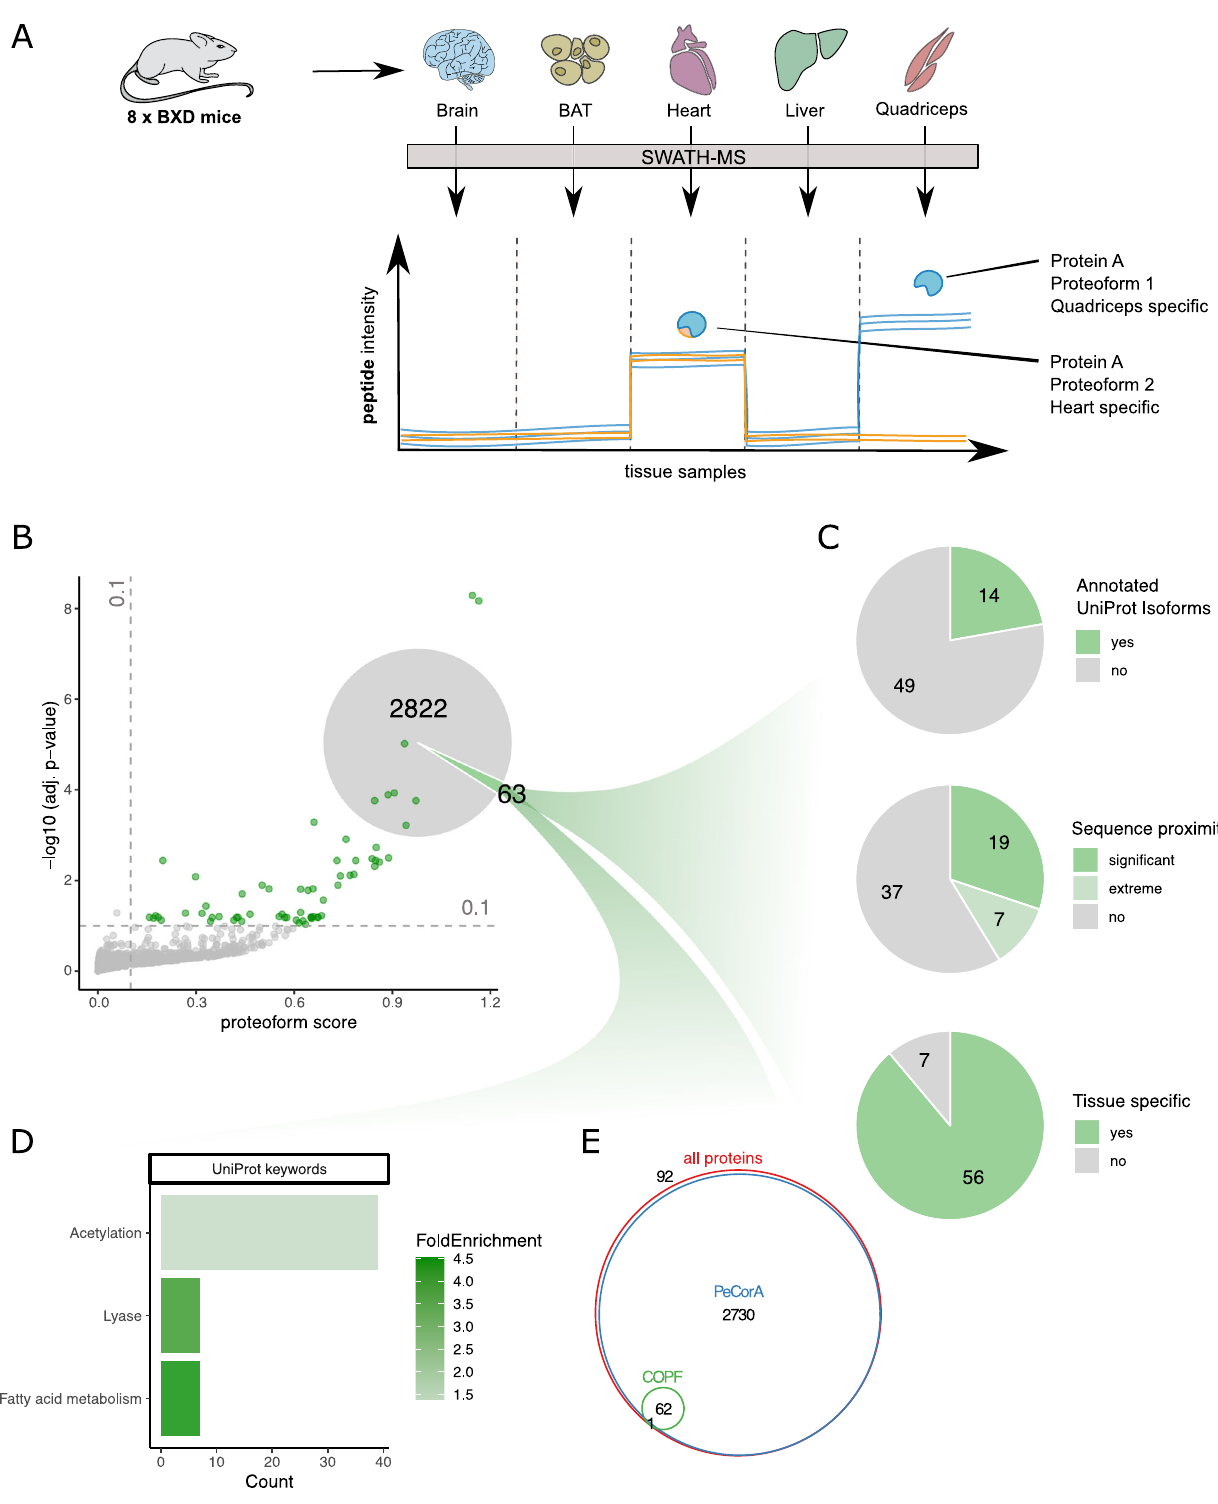
Fig. 6 Global insights into tissue-speci fi c proteoforms in full-proteome SWATH-MS data. A Schematic overview of the experimental design and analysis concept. Tissue samples were obtained from eight different strains of the BXD mouse genetic reference panel. The selected tissues were the brain, brown adipose tissue (BAT), heart, liver, and quadriceps. Each sample was separately processed by bottom-up proteomics using SWATH-MS. The resulting peptide-level quantitative pro fi les can be used to identify tissue-speci fi c proteoform expression, here exempli fi ed by muscle-speci fi c expression of a protein with a heart-speci fi c proteoform (blue and orange) and a quadriceps-speci fi c proteoform (only blue). B Pseudo-volcano plot showing the proteoform scoring results for the mouse tissue SWATH-MS dataset generated by the COPF algorithm. At a multiple-testing corrected p -value threshold of 10% and minimal proteoform score of 0.1, 63 proteins were predicted with multiple proteoform groups. C Assessment of the reported proteoform groups. D UniProt keyword enrichment analysis of the 63 proteins with multiple reported proteoform groups. E Venn diagram showing the overlap of proteoform containing proteins determined by COPF (10% adj. p -value and proteoform score ≥ 0.1) and PeCorA (10% adj. p -value) compared to the total set of proteins in the